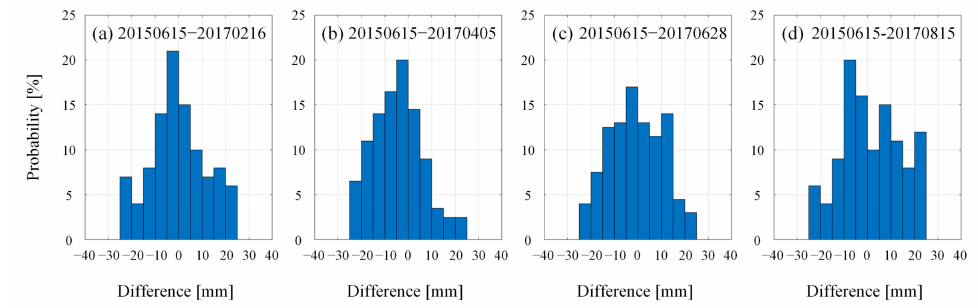
Figure 16. Differences of CT-PIM predicted subsidence with comparison of SBAS-InSAR results (with reference to 15 June